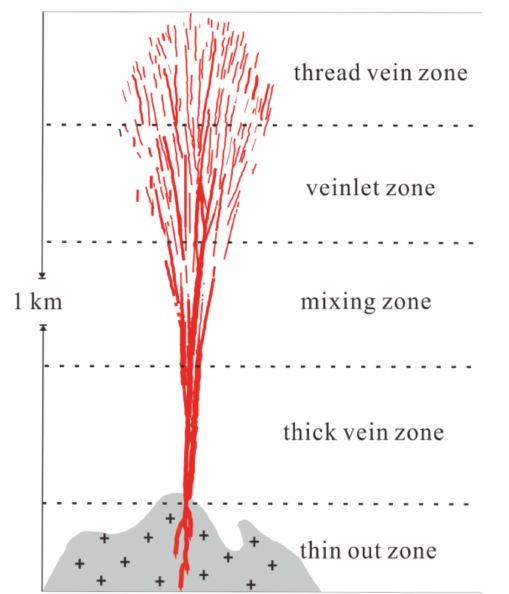
Figure 1. The vertical zoning of vein–type tungsten deposits in southern China (modified from [4]). The vein morphology of the Dajishan tungsten deposit in China was studied by [11] using fractal techniques. One limitation of that study is that vein morphology data only cover a vertical range of 150 m, whereas the whole vein system generally has a vertical dimension of approximately 1000 m (see Figure 1). This difference on the vertical range of quartz veins is caused by at least two reasons. The first reason is that the tunnels being mined for most tungsten deposits in China cover a maximum vertical range of approximately 200–300 m. The second reason is that the shallower parts of the vein systems (e.g., the thread vein zone) are normally barren, and there is no access to those veins. An additional limitation is that the relationship between vein thickness and ore grade was not examined. The present study shows that vein thickness is linked to WO 3 and Sn grades and their correlation may aid in deep exploration. The last major limitation is that the veins are probably the final product of multiple hydrothermal events because tungsten–tin deposits in southern China commonly experienced a few hydrothermal stages [12]. Hence, tracing the growth history of quartz veins at different levels is necessary to better constrain how the five–floor morphological zonation